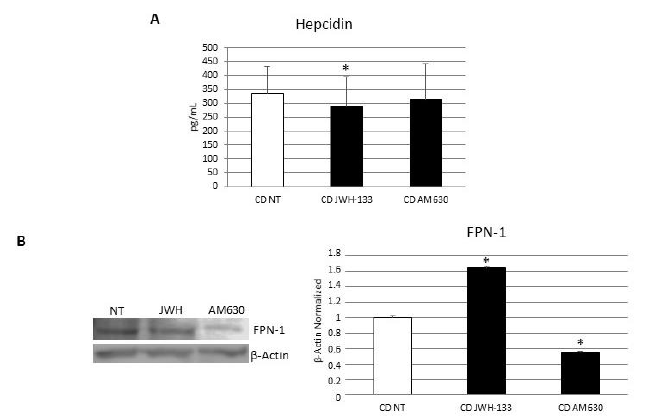
Figure 6. Effects of CB2 modulation on CD macrophages iron metabolism. ( A ) Hepcidin concen- trations (pg/mL) in macrophages from 5 CD patients after 48 h JWH-133 [100 nM] and AM630 [10 µ M] administration determined by ELISA Assay. Histogram shows Hepcidin concentration as the mean ± S.D of independent experiments on each individual sample. The cytokine concentration was determined on a standard concentration curve according to the manufacturer’s instructions. ( B ) Ferroportin (FPN-1) protein expression, determined by Western Blot, loading 15 µ g of total lysate, in macrophages from 5 CD patients after JWH-133 [100 nM] and AM630 [10 µ M] administration for 48 h. The most representative images are displayed. The intensity ratios of immunoblots compared represent the relative quantification for FPN-1 expression, normalized for the housekeeping protein β -Actin, as mean ± SD of independent experiments on each individual sample. A t -test has been used for statistical analysis. * Indicates p ≤ 0.05 compared to